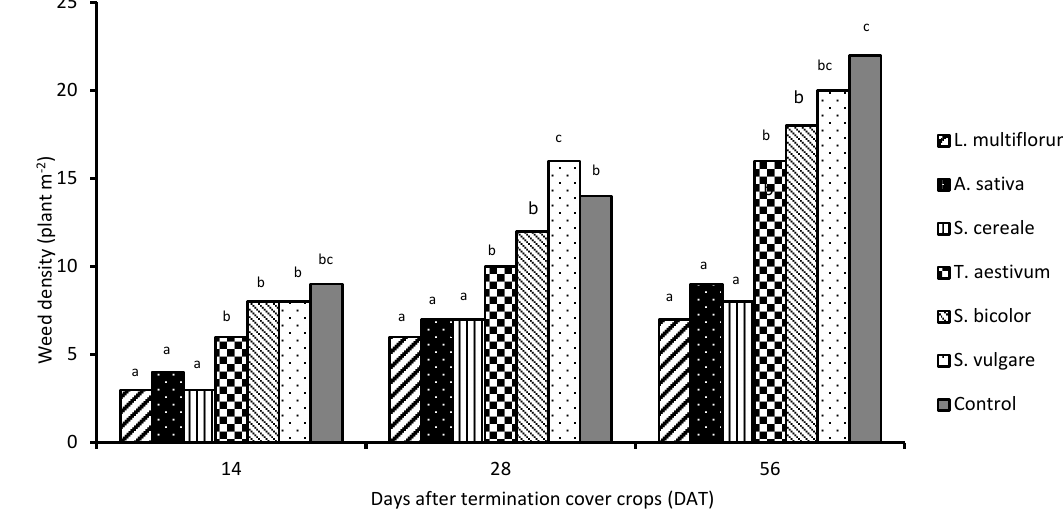
Figure 5. Effects of various cereal cover crops in different vegetable production systems on weed density after different time of cover crop termination. Vertical lines represent standard errors of the means ( p < 0.05) [49,50].